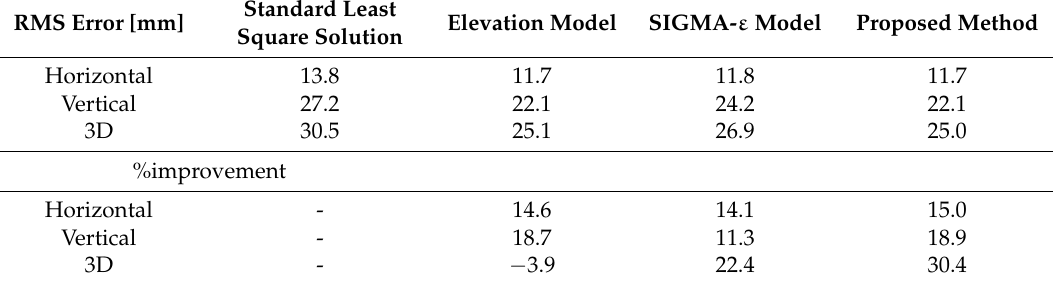
Table 11. RMS errors in horizontal and height components and their percentage improvement (when comparing with the results of other stochastic models) of the tested stochastic models based on the proposed method in Dataset